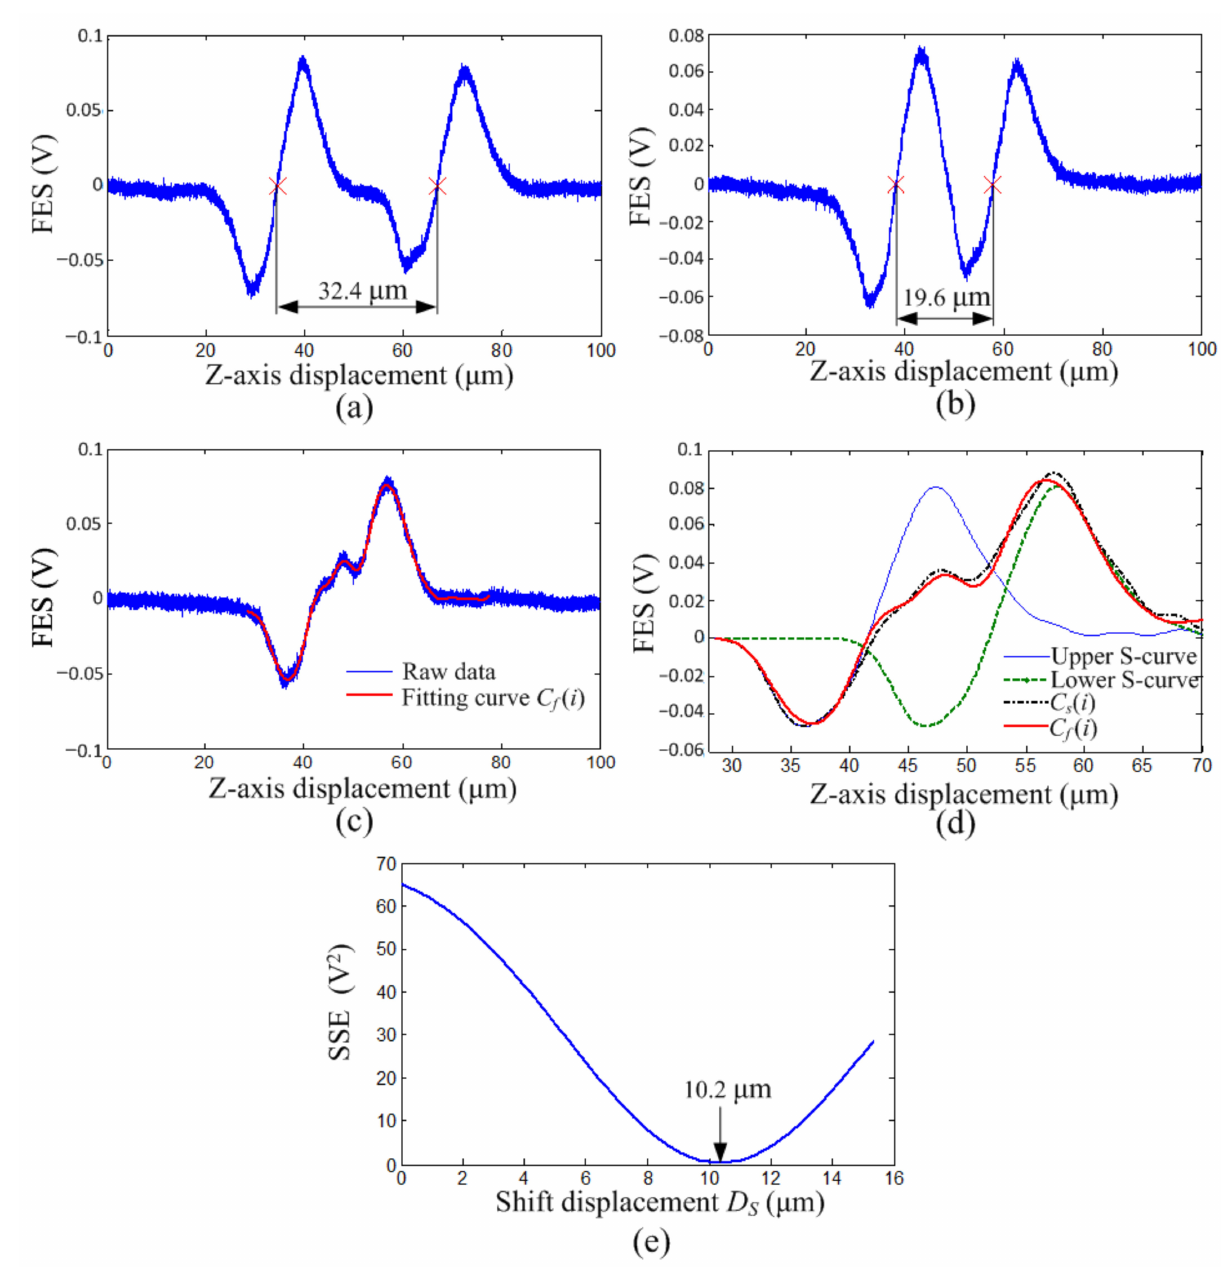
Figure 4. FES vs. z -axis displacement curve for OPP films thicknesses of ( a ) 55, ( b ) 33, and ( c ) 18 µ m. ( d ) Synthetic curves with D s of 10.2 µ m. ( e ) SSE vs. D s